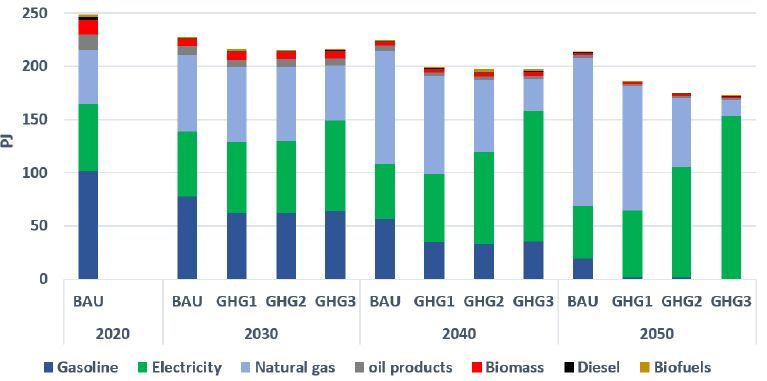
Figure 6. Total final energy consumption by type of energy and environmental